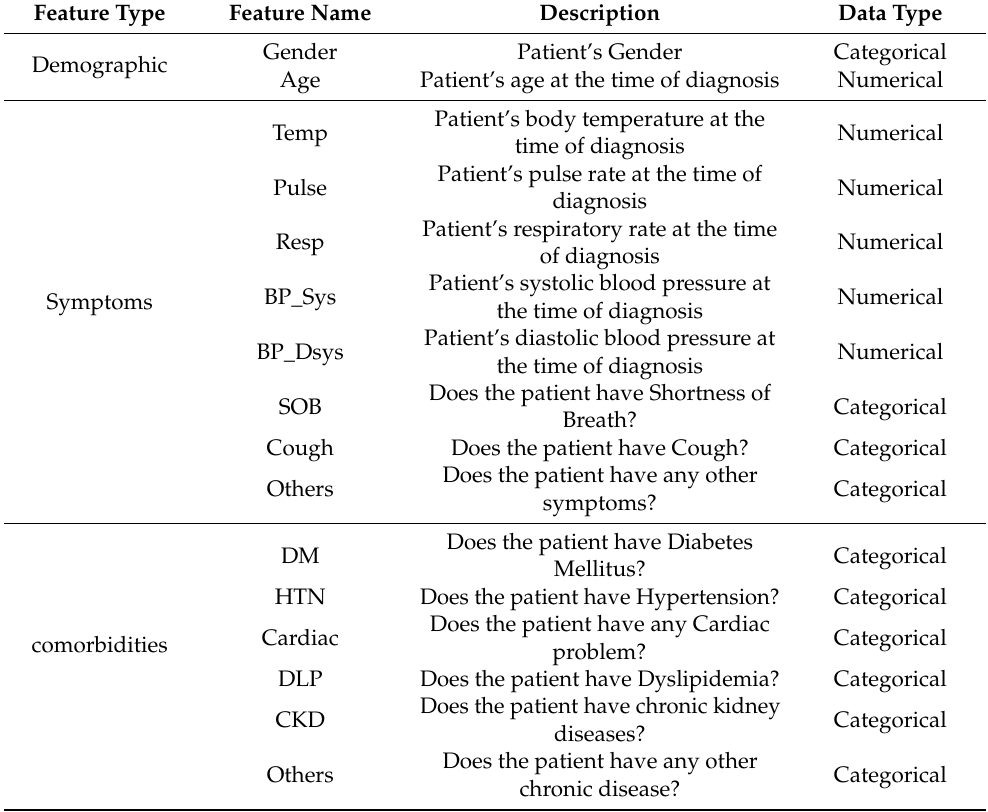
Table 1. Attribute description of the dataset.